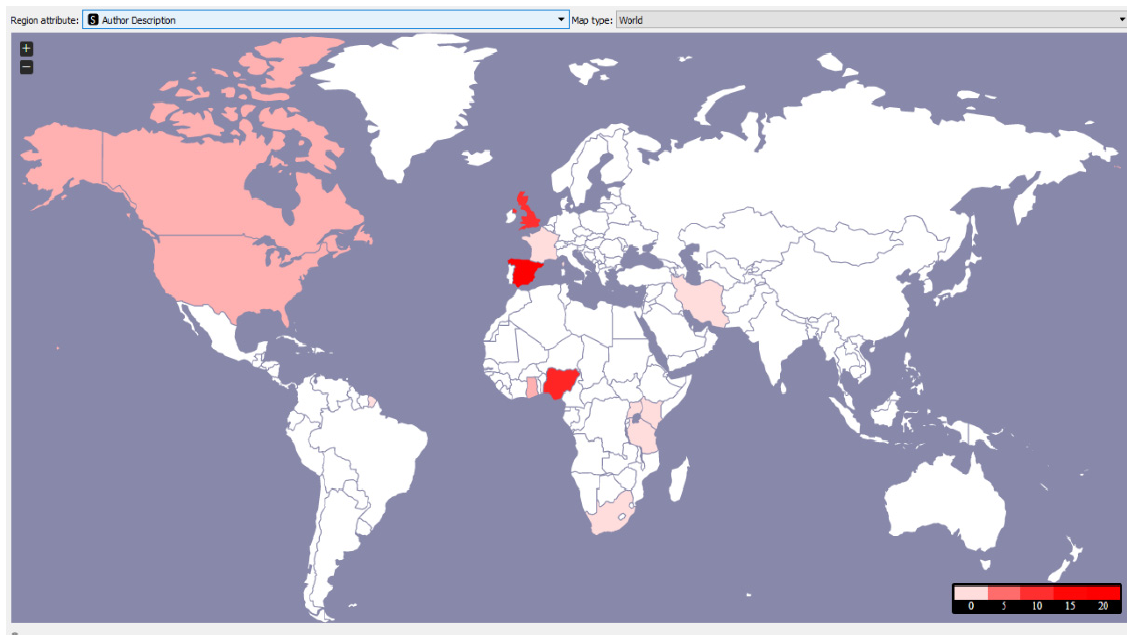
Figure 5. Map Showing Location of Author representing the frequency with color weight. (color code 1) on the world map are Ghana, French Guyana, South Africa, Tanzania, range 5–9 (color code 2) while Northern Ireland, United Kingdom, and Nigeria are in the range 10–14 (color code 3) with 9, 10 and 11, respectively. Finally, Spain fell into the last category with the color 16. From the dataset and contrary to expectation, Spain has the highest number of tweets with the #yahooyahoo on Twitter, followed by Nigeria. How- ever, our tweet dataset also confirmed that most Twitter users prefer to set their location as anonymous. 4.3. Results of Duplicate Detection The dataset was filtered for unique tweets using duplicate detection to remove du- plicate tweets from the 5500 tweets. With the linkage set to single and distance threshold = 0.5, the duplicate detection workflow returned 173 unique clusters and their sizes. Where a cluster represents a unique tweet, and the size is the frequency of retweets or duplication in the dataset. Thus, 173 unique tweets and 5327 duplicates were returned. Tweet C91 is the largest cluster with 484 retweets. Table 3 shows the top twenty tweets, cluster, number of retweets, and content. The 173 unique tweet clusters were adopted for further analysis in the study. To maintain the privacy and the ‘right to be forgotten’ of the tweet’s Authors, their Twitter handles were anonymized using serial uTweet1, …, uTweet 173 for Unique tweet 1 to 173, respectively. Table 3. Top twenty tweets showing the cluster, number of retweets, and content. S/N Cluster No. of Retweet